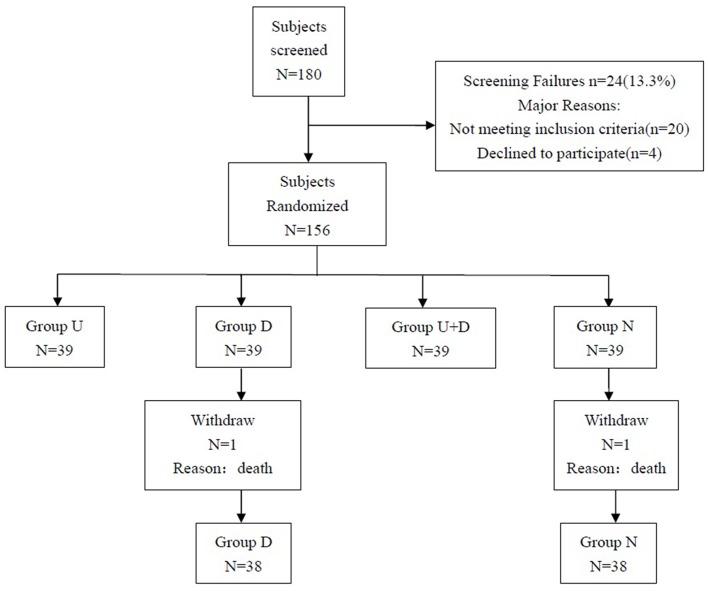
Patient recruitment flowchart.